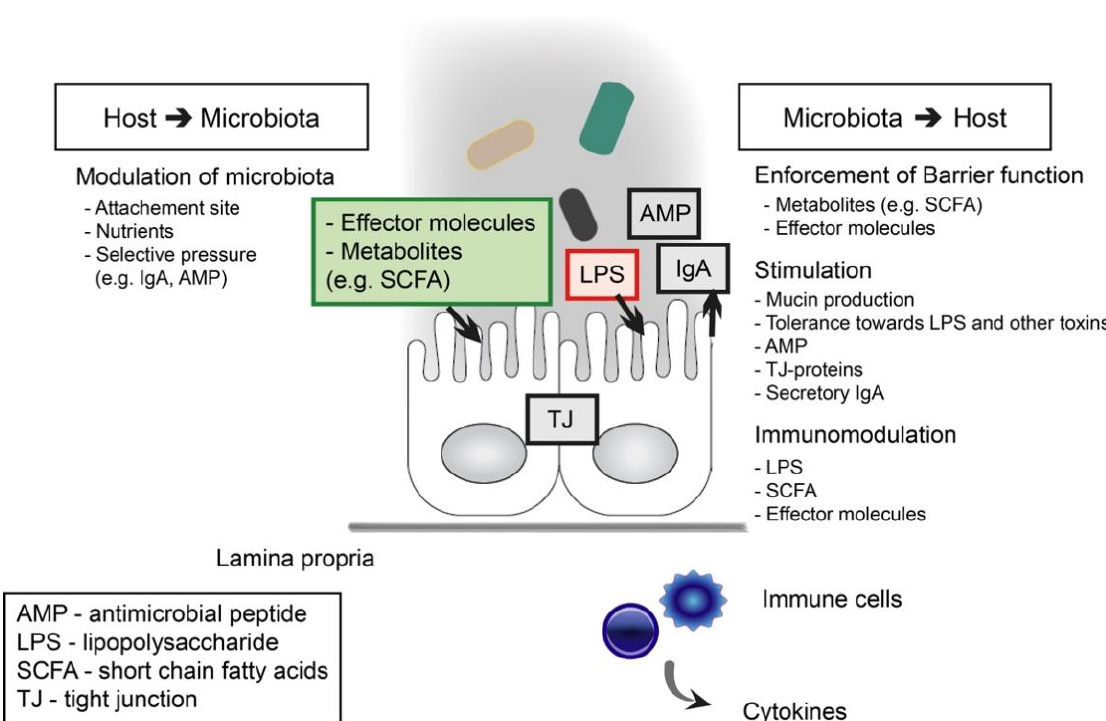
Figure 1. Host-microbiota interactions affecting the epithelial barrier function.